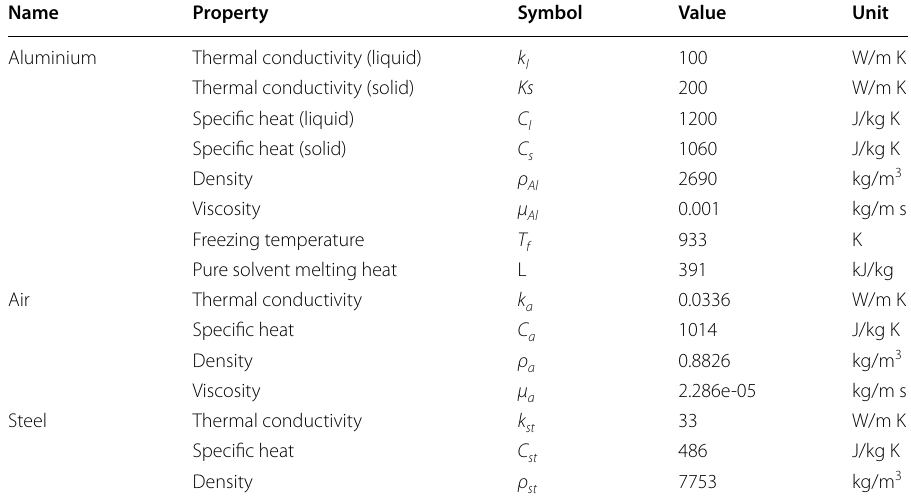
Table 2 Thermo-physical properties of the aluminium, air, and steel used in the simulations